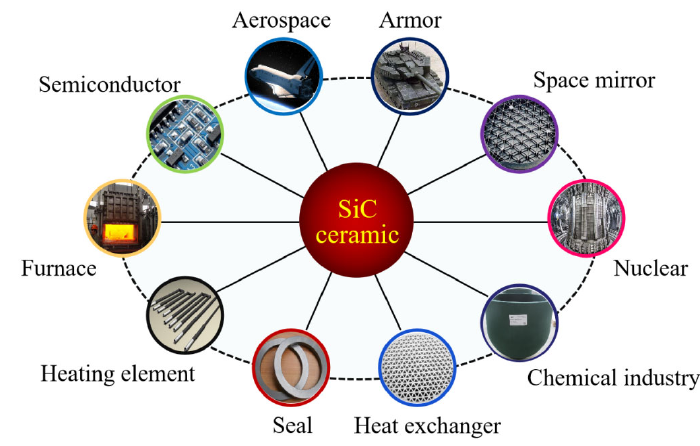
Fig. 1 Applications of SiC ceramic in military and engineering fields.